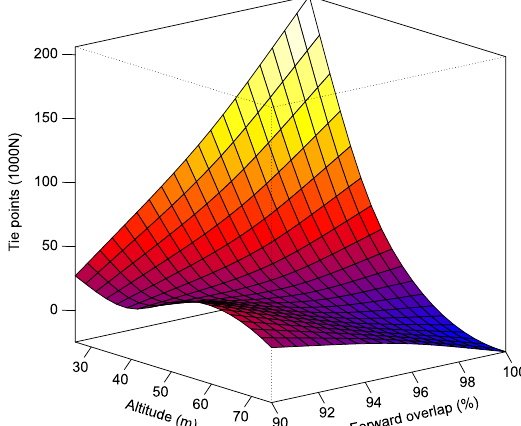
Figure 8. Generalised additive model (GAM) for identified tie point numbers in relation to drone altitude (above ground) and forward image overlap at a sensor resolution of 4 Mpx.